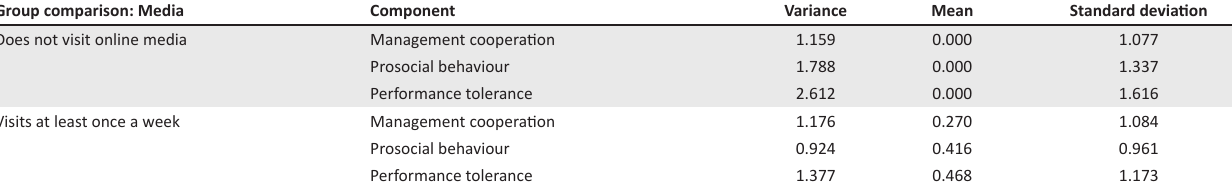
TABLE 7: Variances, means, and standard deviations of fan engagement in the media groups. Group comparison: Media